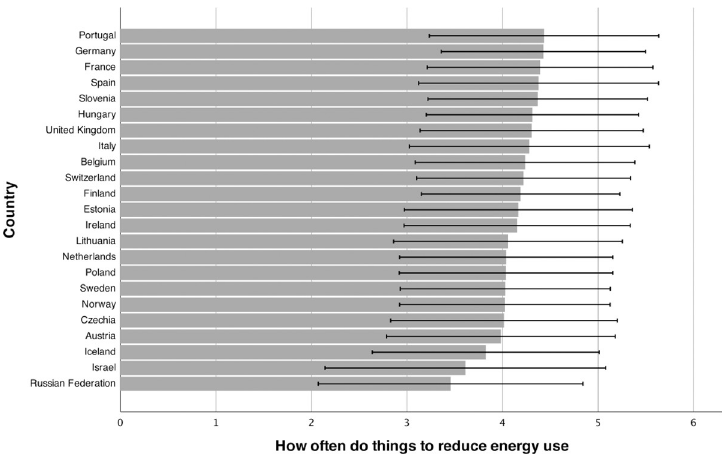
Fig 1. Mean energy curtailment behavior. Note. Means weighted with a combination of post-stratification weights and population weights. The figure includes +/- 1 SD.